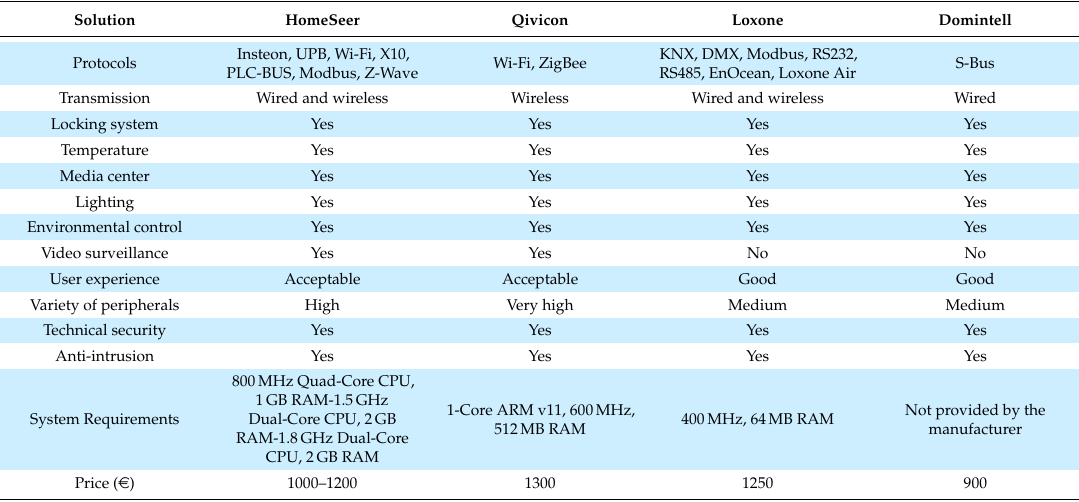
Table 4. Comparison of the features of commercial home automation